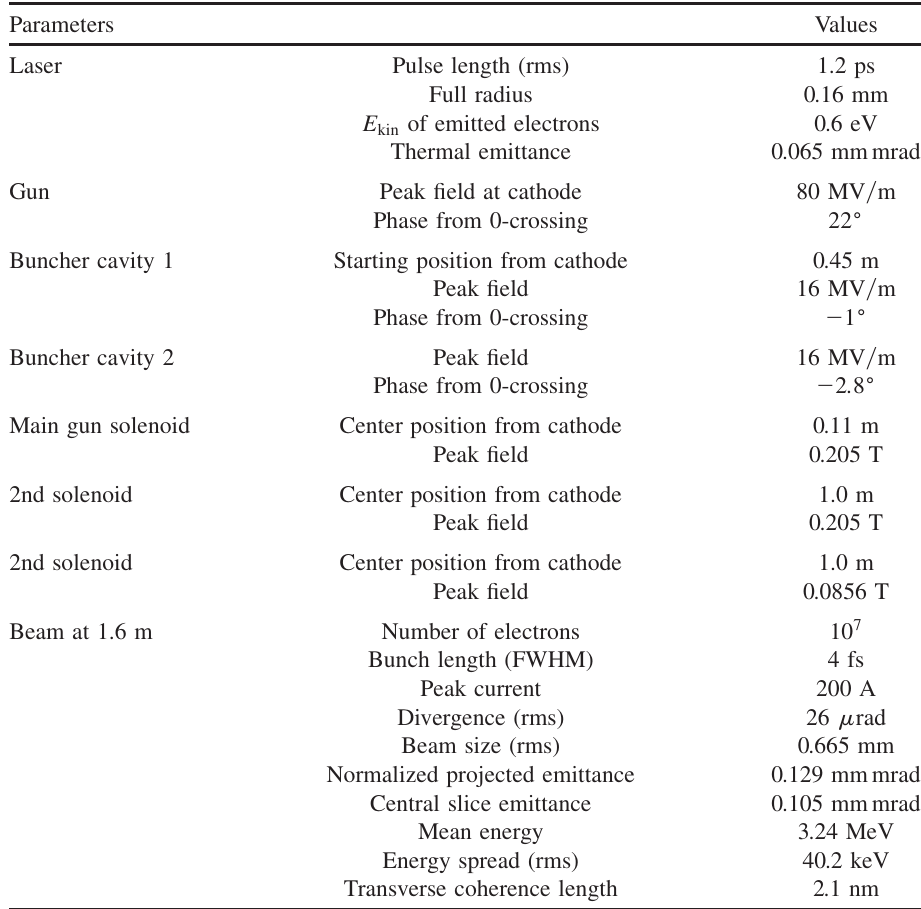
TABLE I. Simulation input parameters of laser, gun, and buncher and the simulation result of the beam parameters with ASTRA at 1.6 m.